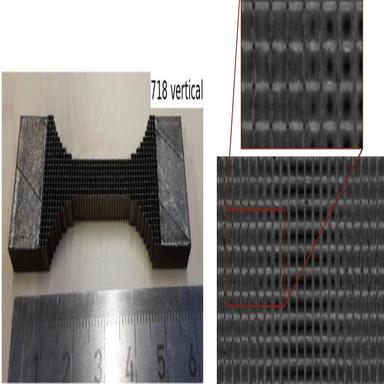
Inconel⃝R